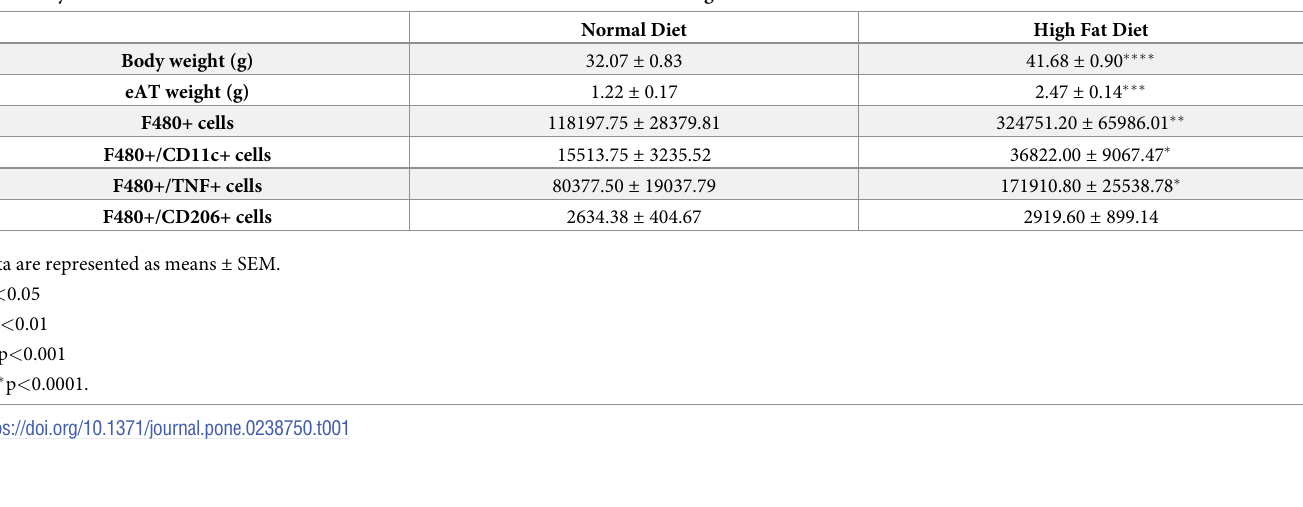
Table 1. Systemic effects of HFD and ND on C57BL/6 male mice after 10 weeks of